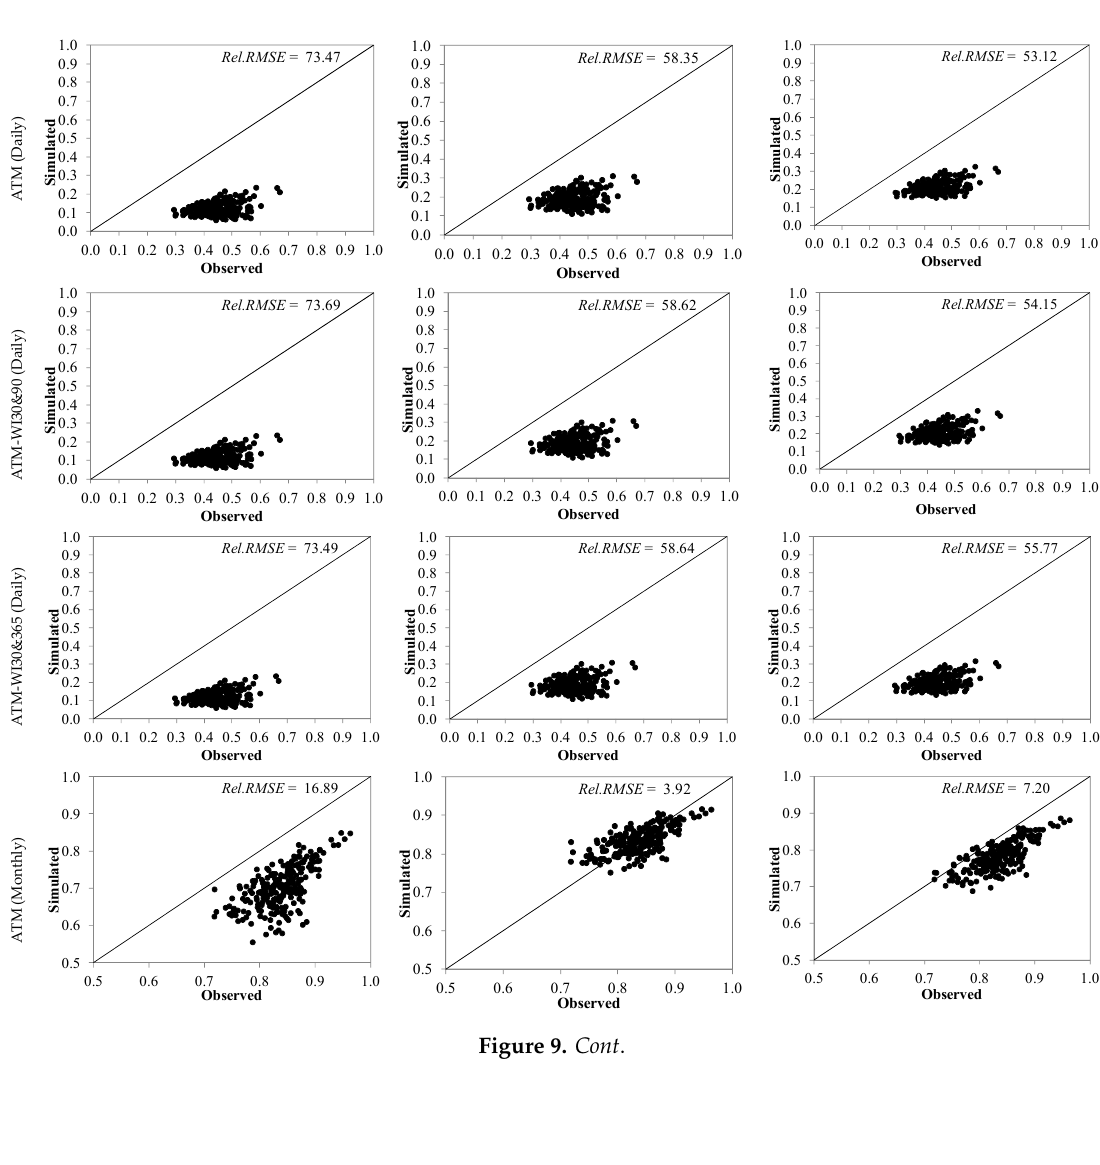
Figure 8. Scatter plots of observed and models simulated daily, monthly and annual cross correlations using multisite model (Calibration period). Rel. RMSE values are shown on the top right of each plot: ( a ) using RegressionYrly model; ( b ) using Regression366 model; and ( c ) using